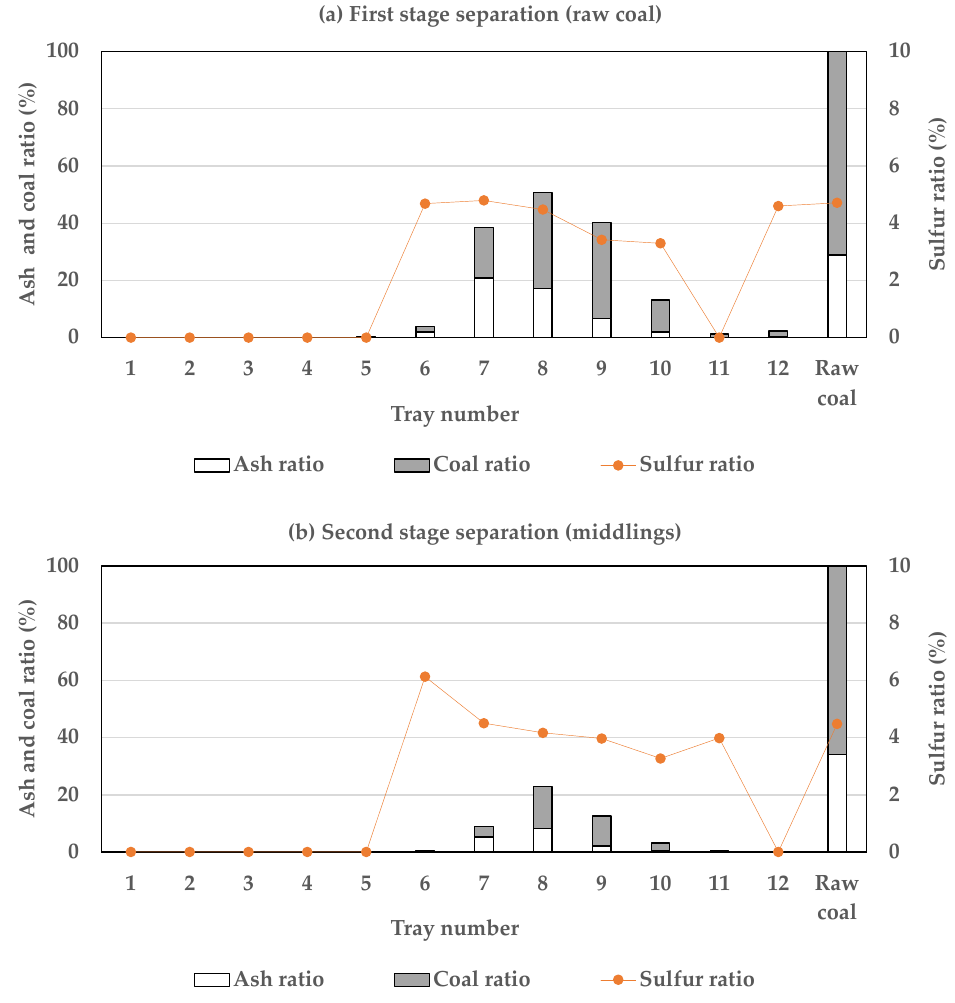
Figure 9. The results of a dry coal cleaning system with two-stage corona electrostatic processes: ( a ) the first stage of cleaning; ( b ) the second stage of cleaning.